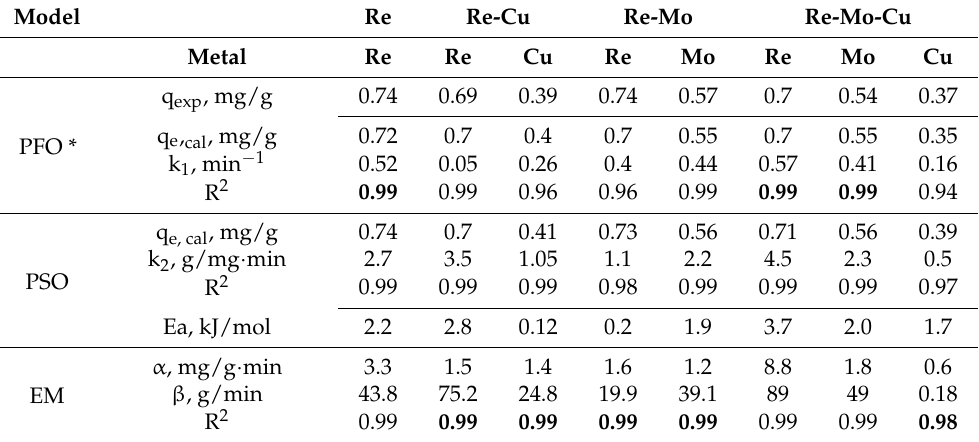
R 2 0.99 0.99 0.99 0.99 0.99 0.99 0.99